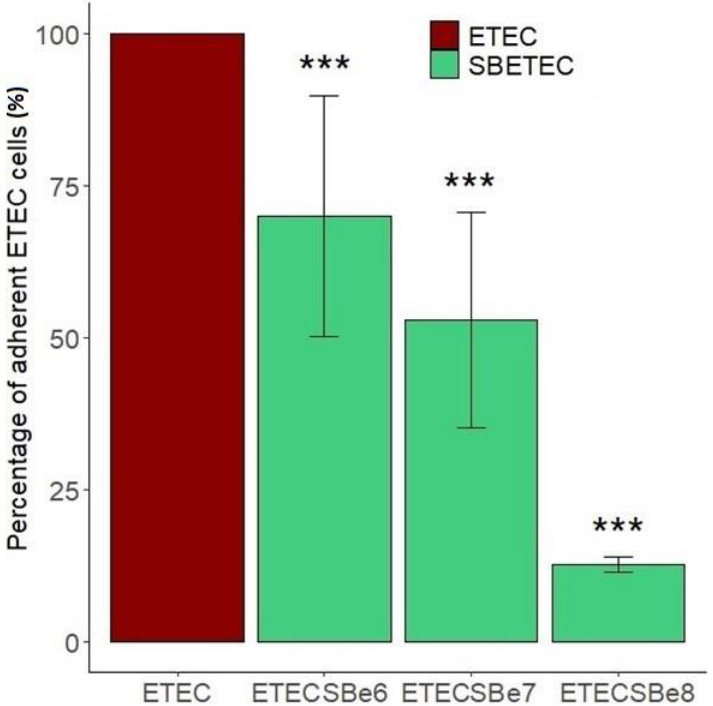
Figure 1. Percentage of adherent ETEC cells on IPEC-J2 intestinal cells pre-treated or not with different doses of SB CNCM I-1079. The concentration of ETEC adherent cells on control IPEC-J2 cells (non-treated with SB yeasts) was normalized to 100% ( n = 3). The denominations e6, e7, and e8, respectively, correspond to the doses of 10 6 , 10 7 , and 10 8 CFU/well of SB incubated on the ETEC-challenged IPEC-J2 cells ( p value codes: *** < 0.000).